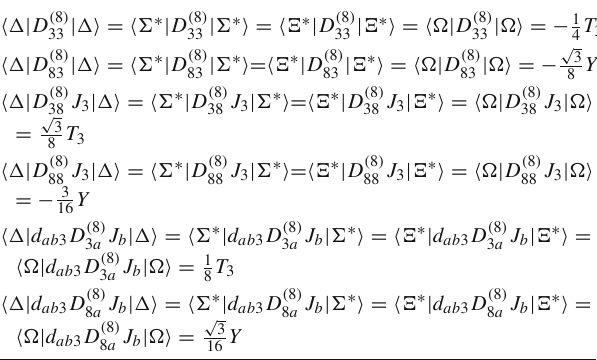
Table 9 The matrix elements of the collective operators of the leading terms and the 1 / N c rotational corrections to the magnetic dipole form factors